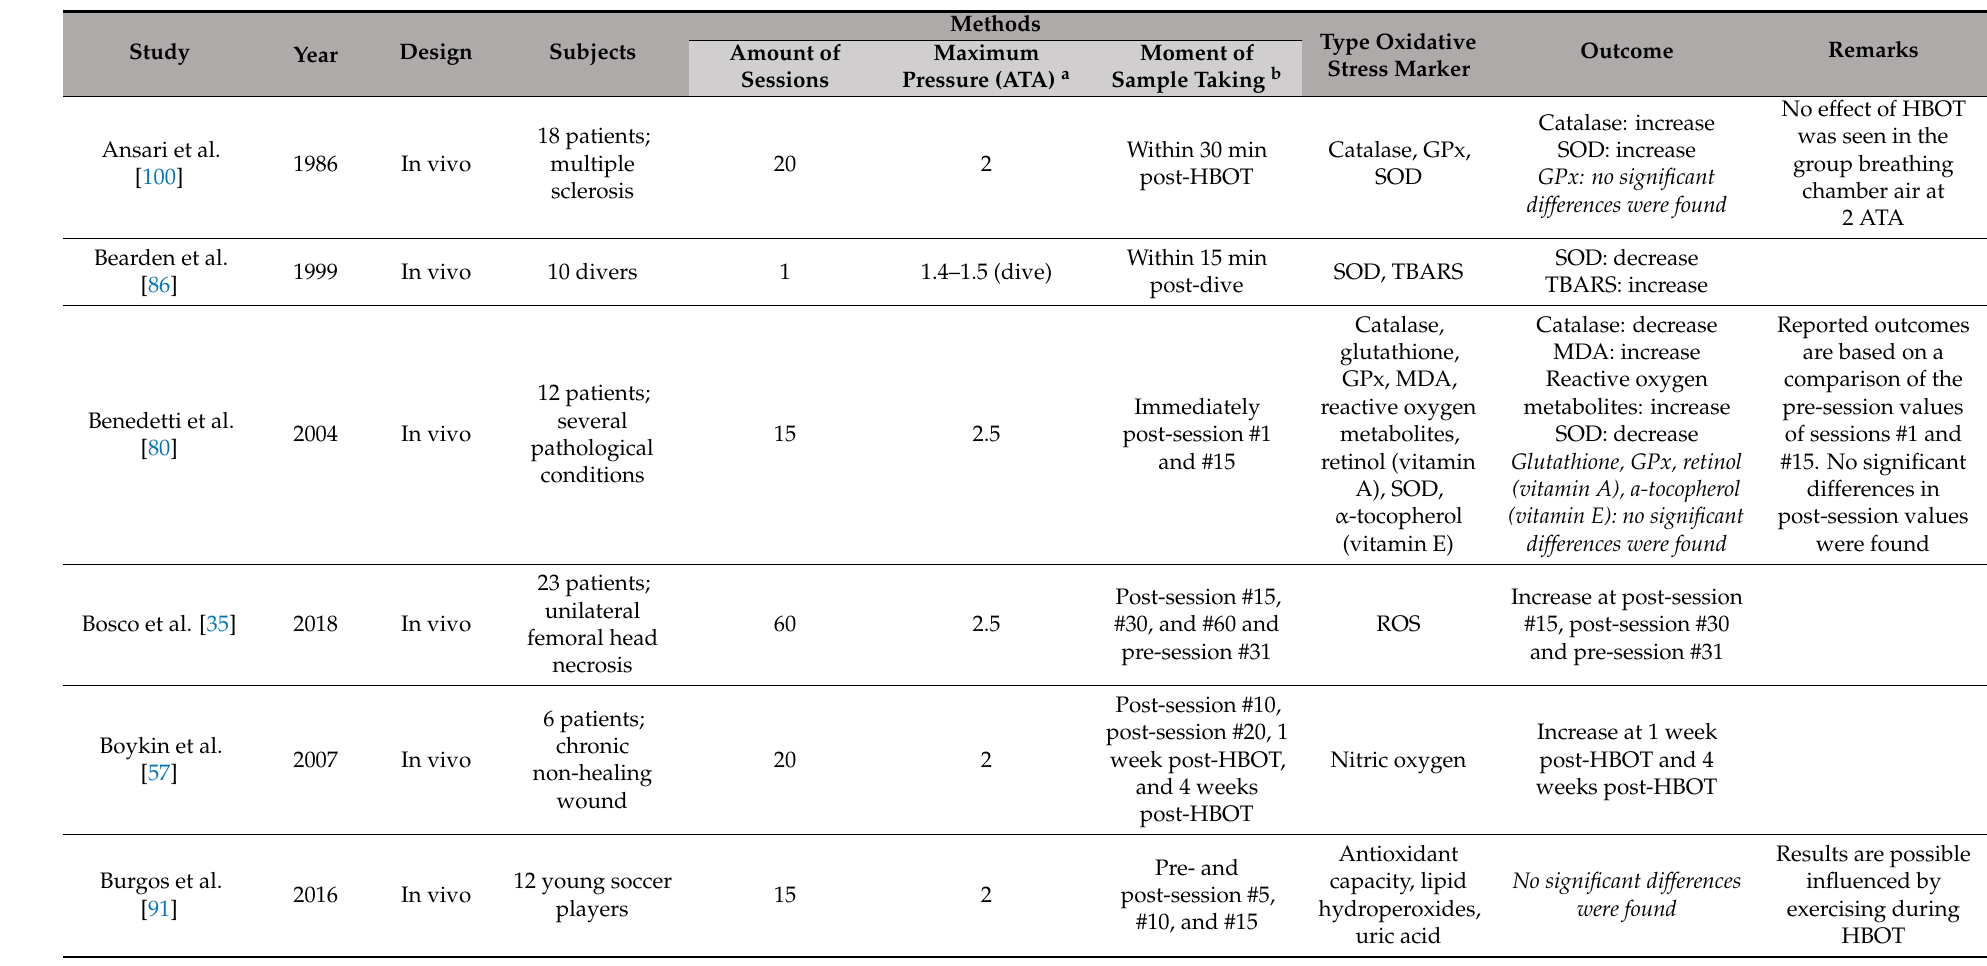
Table A3. Retrieved results on oxidative stress markers in